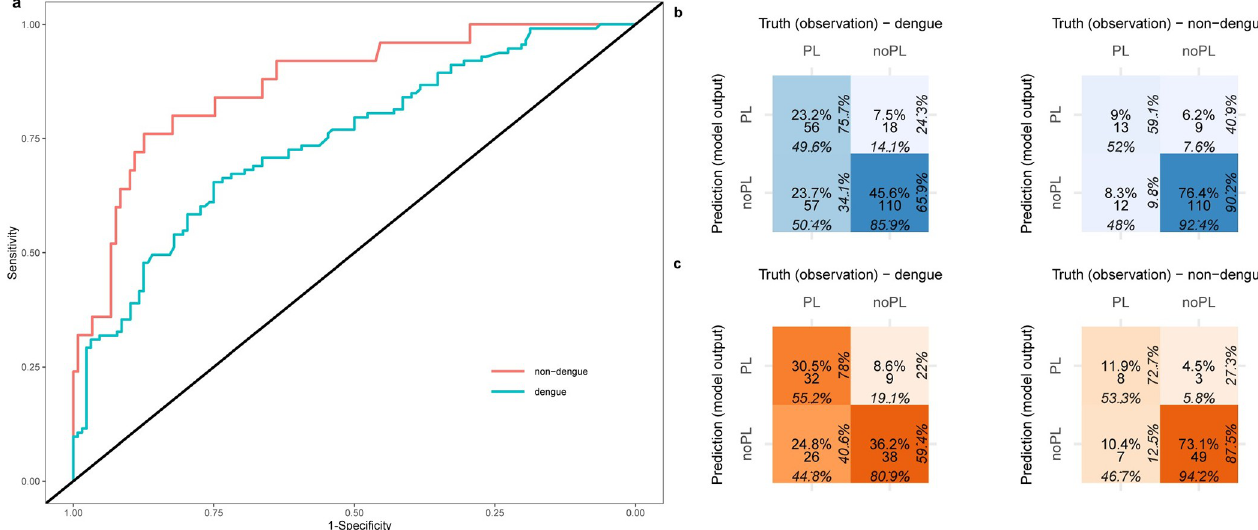
Fig 3. An overview of the model fairness of the final model: DENV 5F-AS . a) ROC curves for the dengue and Non-dengue subsets of the test set. b) Confusion matrix (in blue) for the DENV 5F-AS on the dengue and non-dengue subsets of the test set, percentages in each direction provide the proportion of instances that belong to each row or column of the confusion matrix. PL: plasma leakage and noPL: no plasma leakage. The colour intensity is proportional to the ratio of the instances of a matrix cell to the total number of instances, c) confusion matrix (in orange) only including the earliest instance of patients for dengue and non- dengue subsets of the test